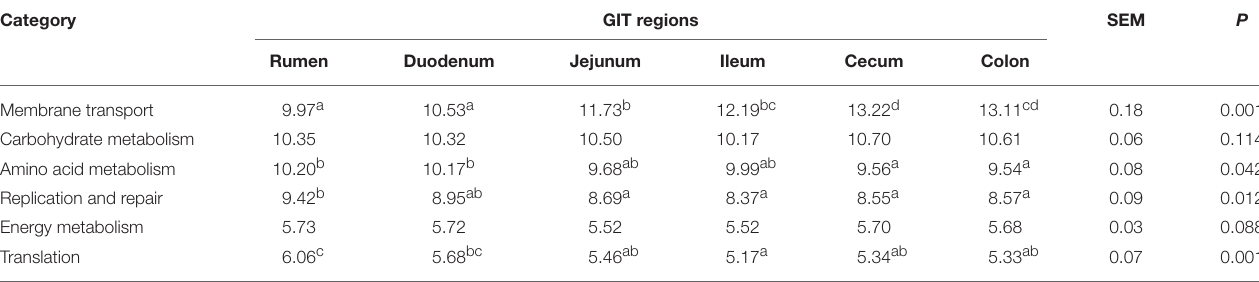
TABLE 1 | Comparison of the six dominant KEGG gene pathways among different GIT regions. Category GIT regions SEM P Rumen Duodenum Jejunum Ileum Cecum Colon Membrane transport Carbohydrate metabolism